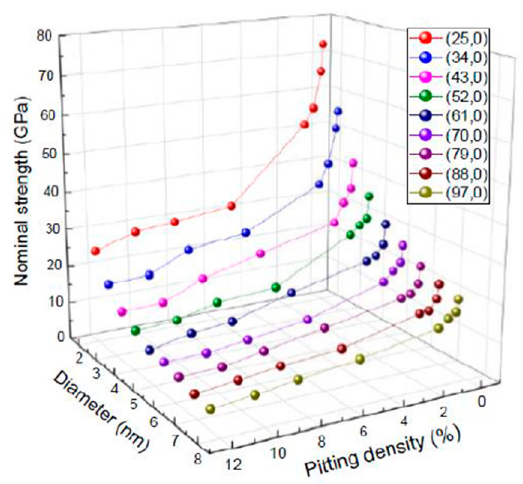
Figure 3. Relationships between carbon nanotube (CNT) diameter, pitting density, and nominal tensile strength of a single-walled CNT (SWCNT).